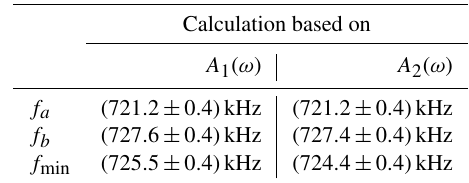
Figure 8. Amplitude curves obtained with Eqs. (21) and (22) for both subsystems of the circuit model with damping and without ex- ternal interaction from Fig. 7. Table 4. Calculated resonance frequencies f a,b of the coupled sys- tem for both subsystems obtained with the circuit model of Fig. 7 that includes damping. Furthermore the frequency f min , which cor- responds to the amplitude minimum between the two resonance peaks is